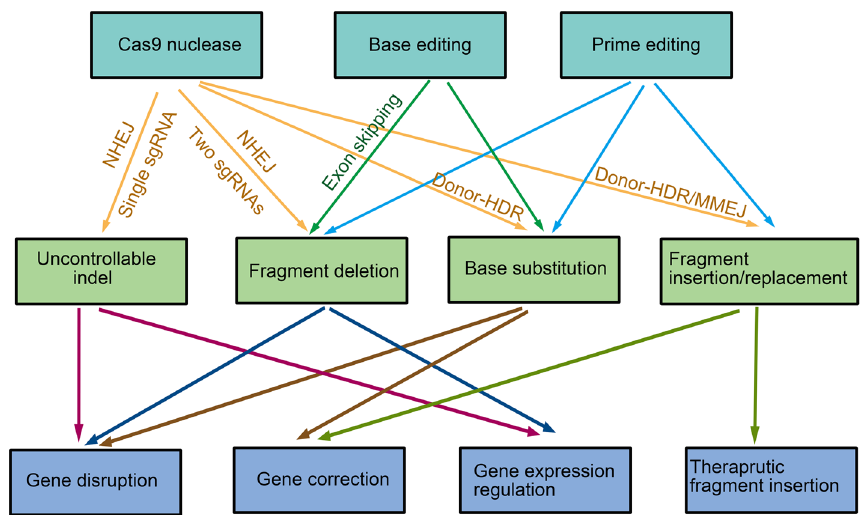
Fig. 4 Therapeutic Strategies of Cas9 nuclease, base editor and prime editor. Different Cas9-related editing tools (above) can produce different types of edits to the genome (middle) and thus can cause different changes to the corresponding genes